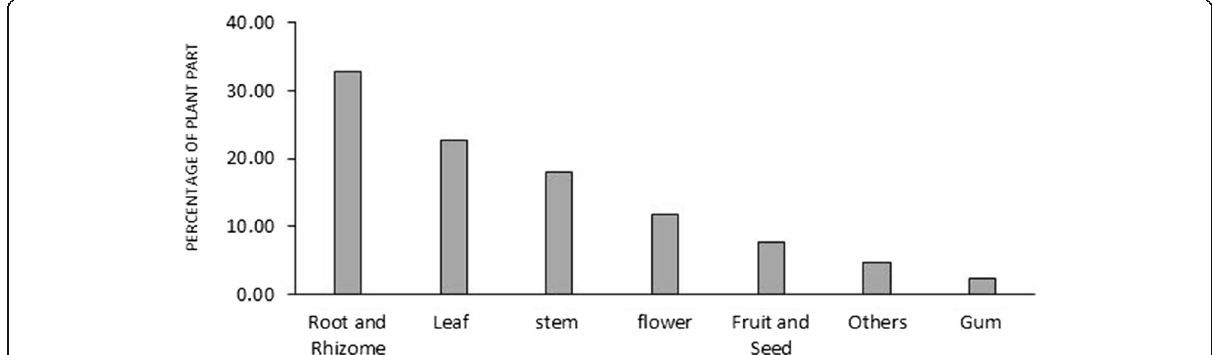
Fig. 1 The percentage of plant parts used for the treatment of Heart